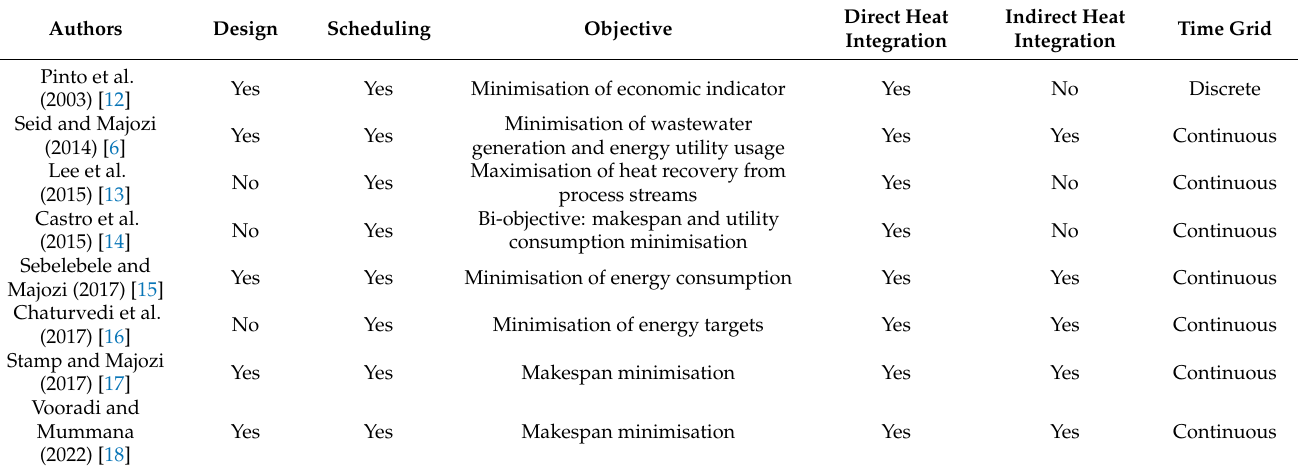
Table 1. Brief summary of referenced papers on heat